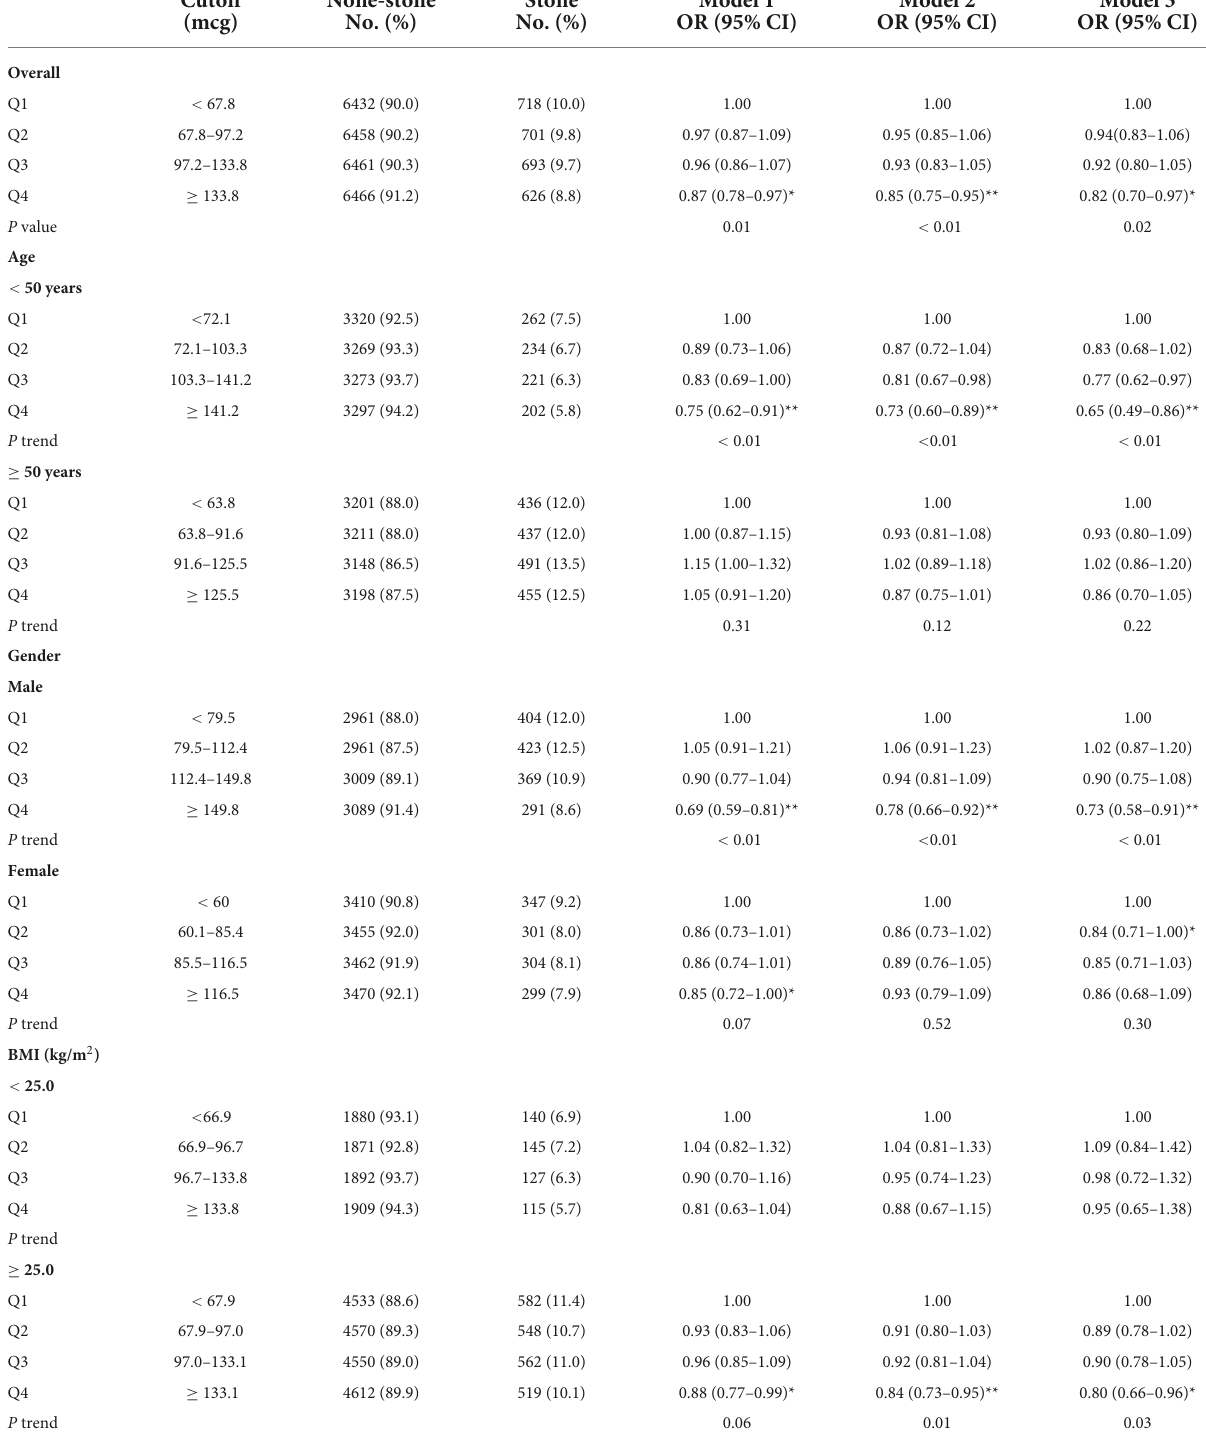
TABLE 2 Multivariate analysis of kidney stones by quartiles of selenium intake, National Health and Nutrition Examination Survey (NHANES) 2007–2018. Cutoff None-stone (mcg) No.